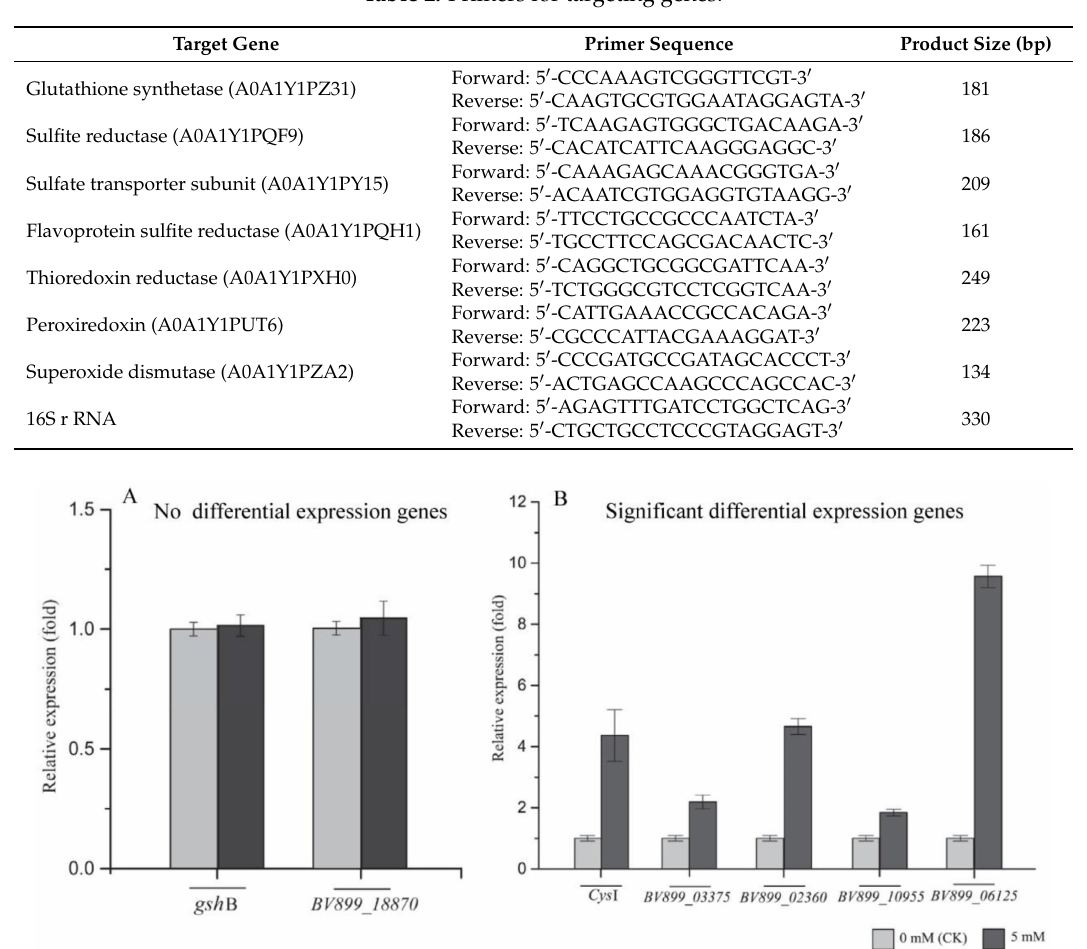
Figure 9. Real-time PCR results of expression levels of selected genes ( A ) Not significant differentially expressed genes, ( B ) significant differential expression of genes. Data are shown as fold changes by calculating expression levels of selenite treated samples compared to untreated (defined as 1). Data represent an average of three biological replicates ±